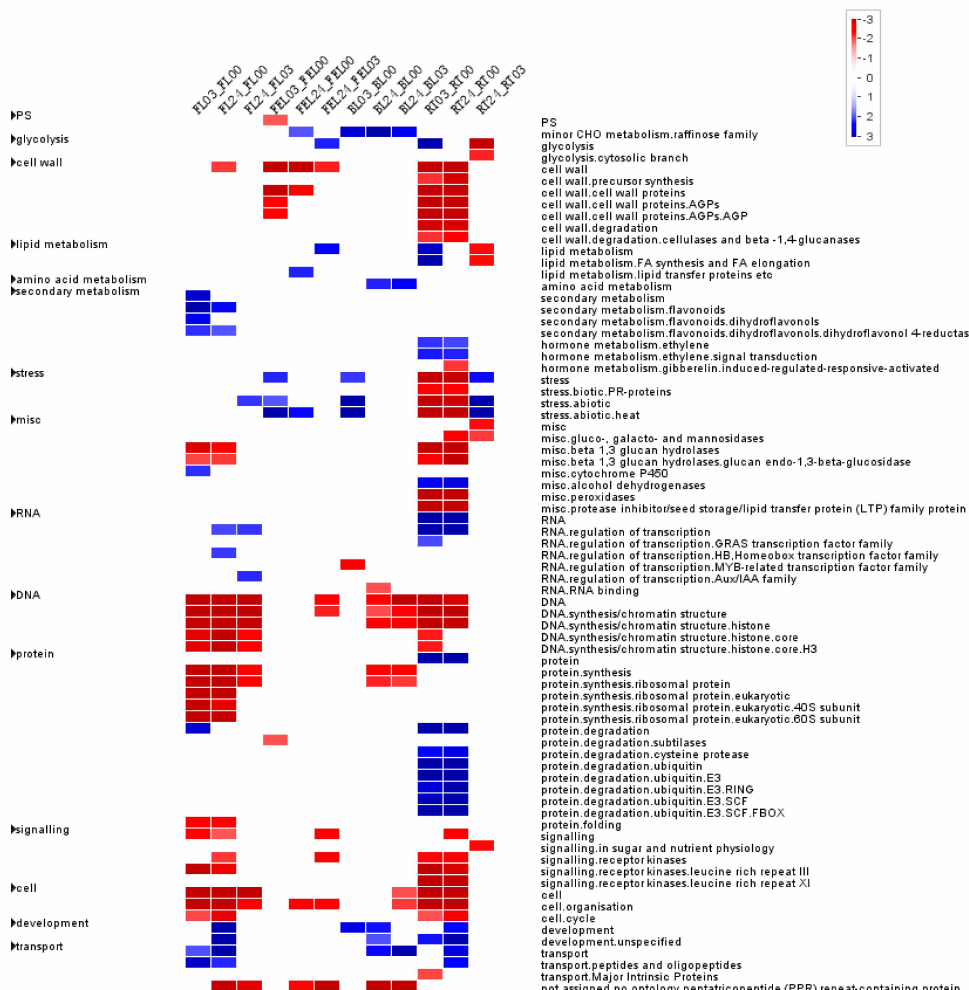
Figure 3. Functional category enrichment of DEGs by pair-wise comparison. Each column represents the DE genes that are dramatically up ( blue ) or down ( red ) regulated when comparing two samples indicated at the top, while each row represents a functional category derived from the MapMan software. Enriched functional categories were identified based on Wilcoxon test that embedded in PageMan where ORA cutoff value was set to 1 and p -values were Benjamini-Hochberg